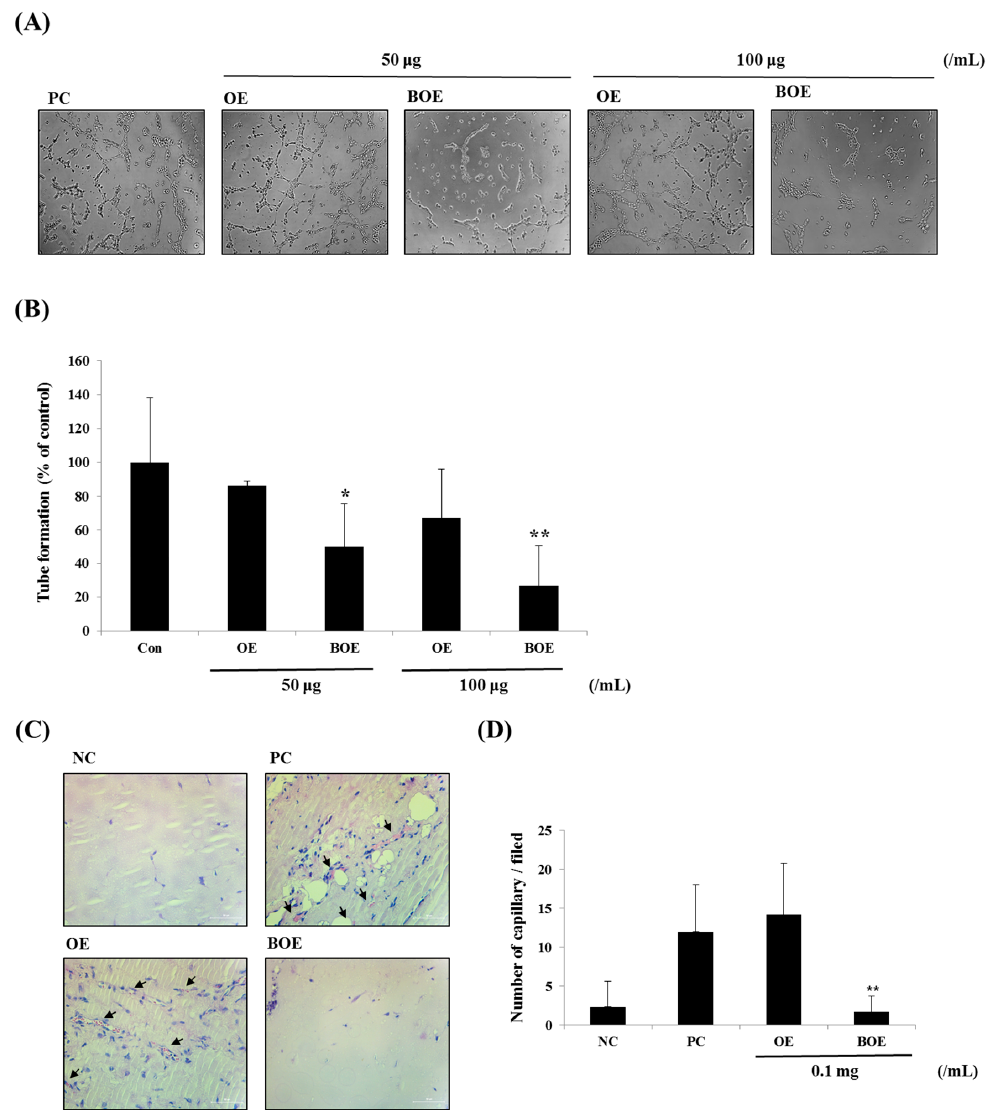
Figure 3. Effects of OE and BOE on tube formation of Ms-1 cells. ( A ) Cells were pretreated with OE or BOE and seeded onto plates pre-coated with matrigel. Representative images were photographed with a microscope at 200× magnification. ( B ) Tube lengths were quantified using ImageJ. ( C ) Matrigel plugs were harvested and stained with hematoxylin and eosin stain (H&E). The arrows represented infiltrating vessels. Representative images were photographed with a microscope at 400× magnification. ( D ) The number of vessels was counted. p < 0.01 (**); p < 0.05 (*). Bars represent mean ± SD.